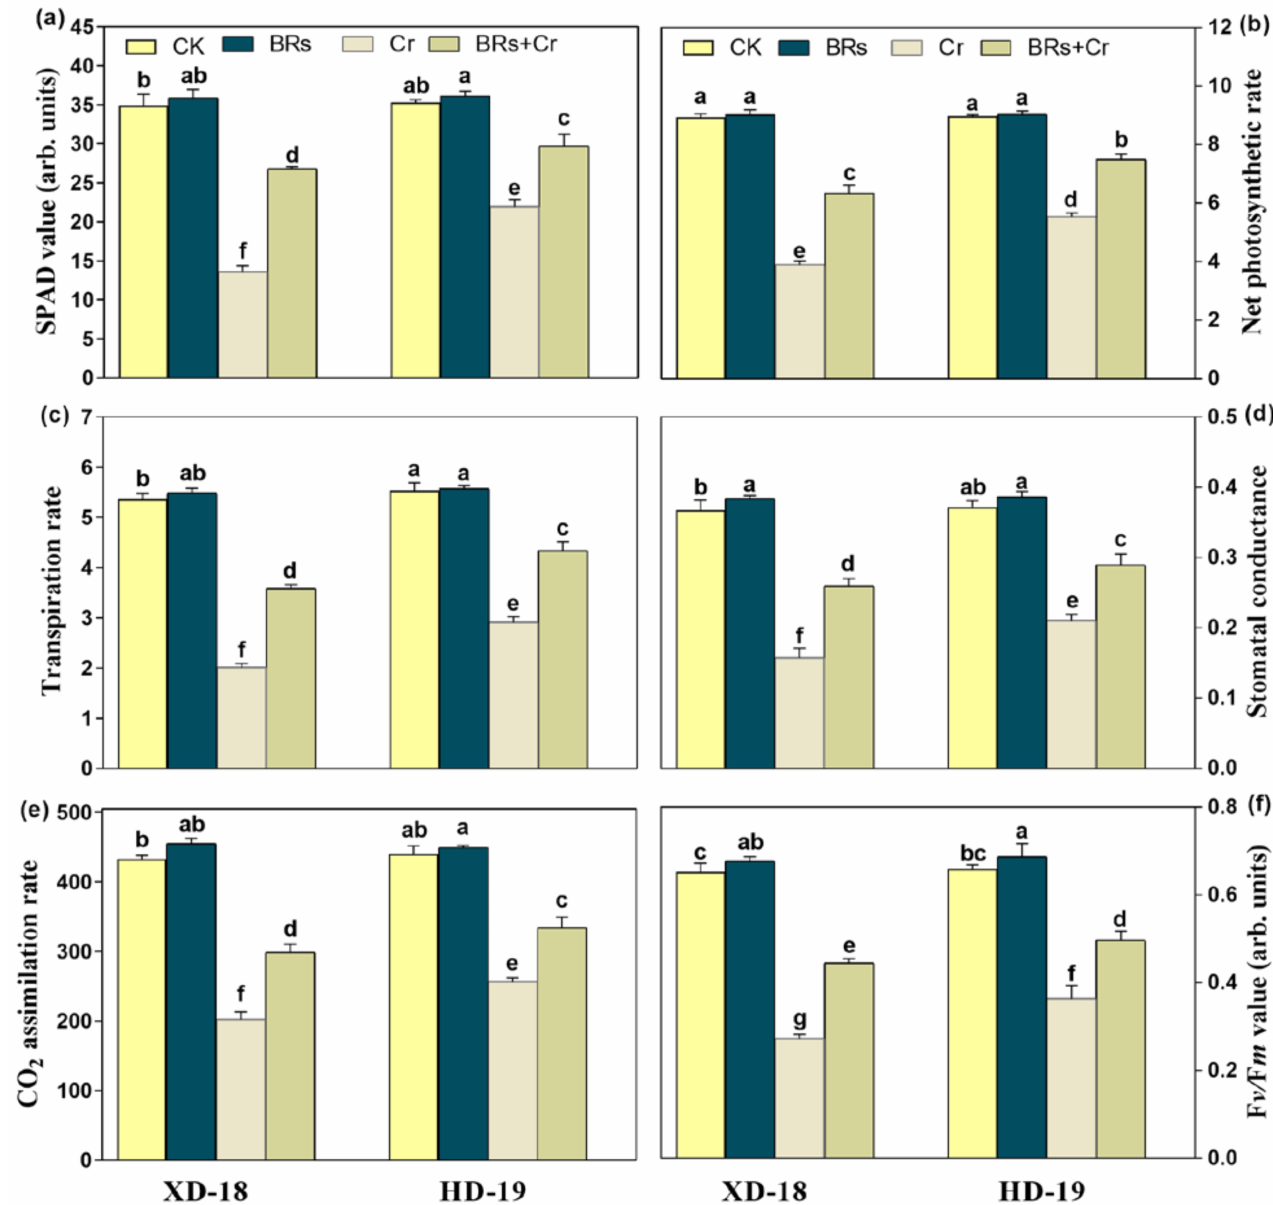
Figure 1. Effect of foliar applied BRs (0.01 µ M) on photosynthetic attributes [( a ) SPAD values, ( b ) Photosynthetic rate, ( c ) Transpiration rate, ( d ) Stomatal conductance, ( e ) CO 2 assimilation rate, and ( f ) F v /F m value] in the leaves of two soybean genotypes (XD-18, HD-19) under/without chromium (Cr) (0 and 100 µ M) stress. Values are the means ± SD of four independent replicates. Different alphabetical letters on bars indicate significant differences among the treatments ( p < 0.05) by the least significant difference